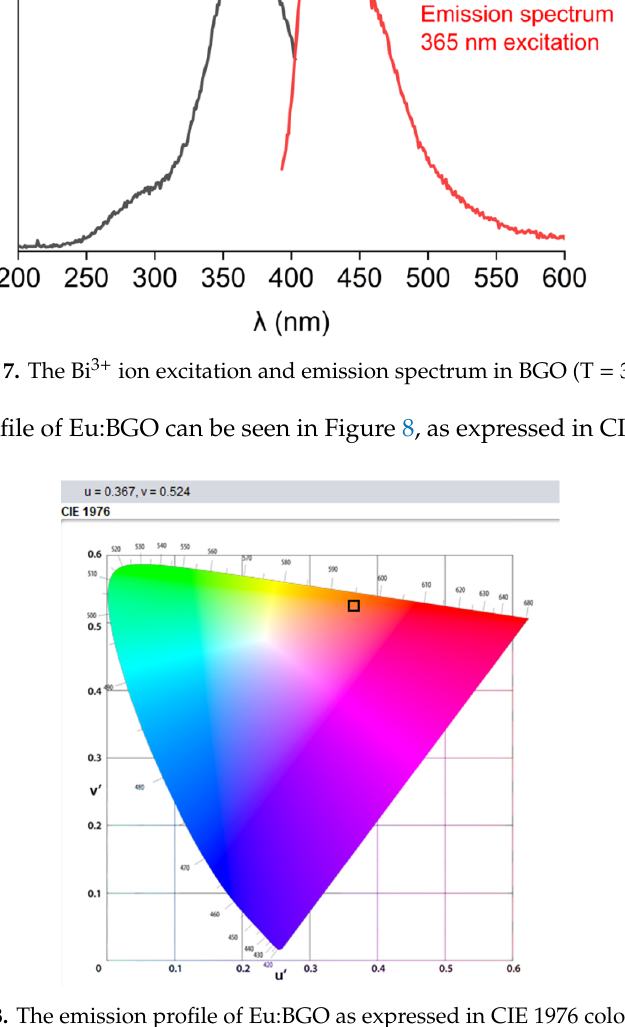
Figure 9. Bi 3+ decay times relative to the Eu 3+ concentration (measured at T = 300 K).